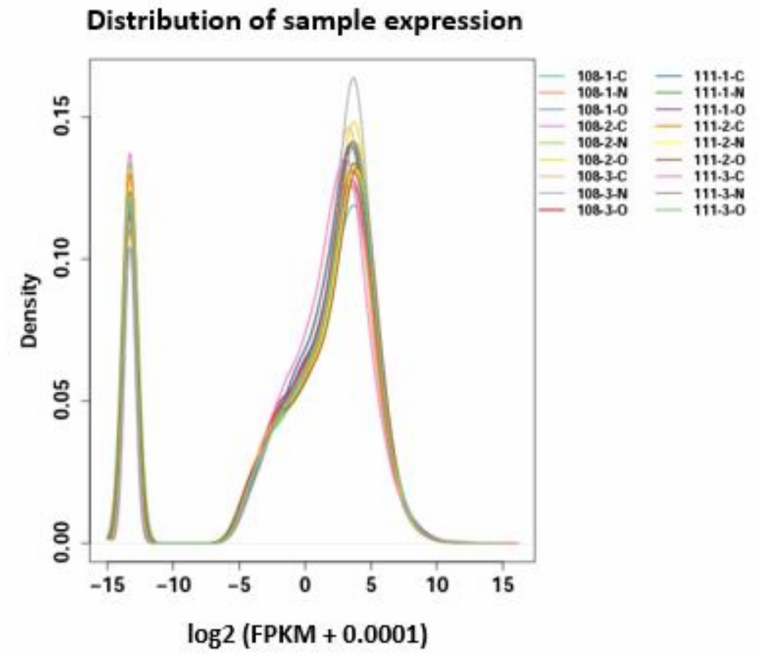
Figure 1. Gene expression density map of ‘108’ and ‘111’ treatment groups. The di ff erent samples are represented by di ff erent colors.